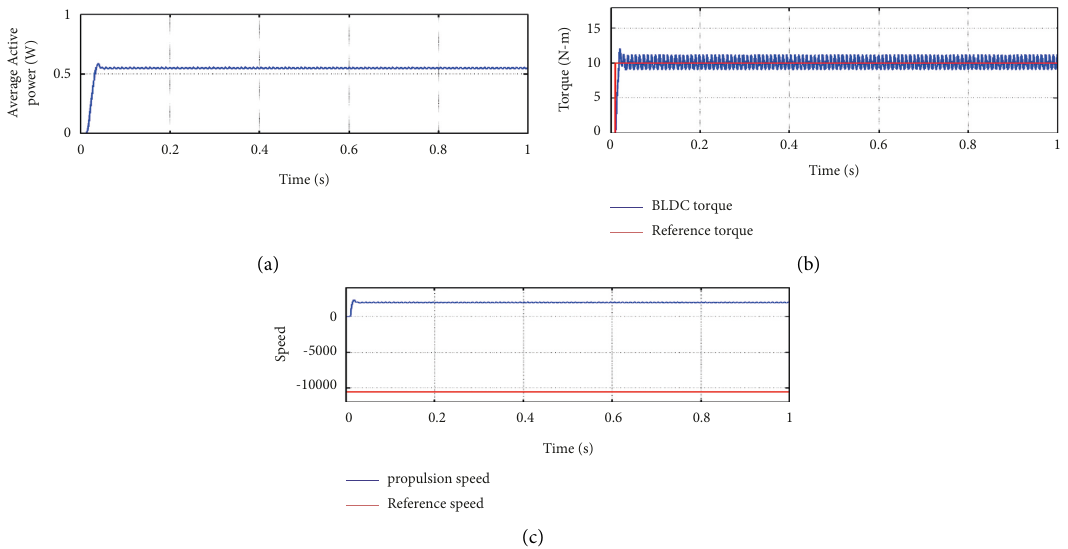
Figure 20: ANFIS designed. (a) Active power. (b) Reference speed and propulsion speed. (c) Reference torque and BLDCM